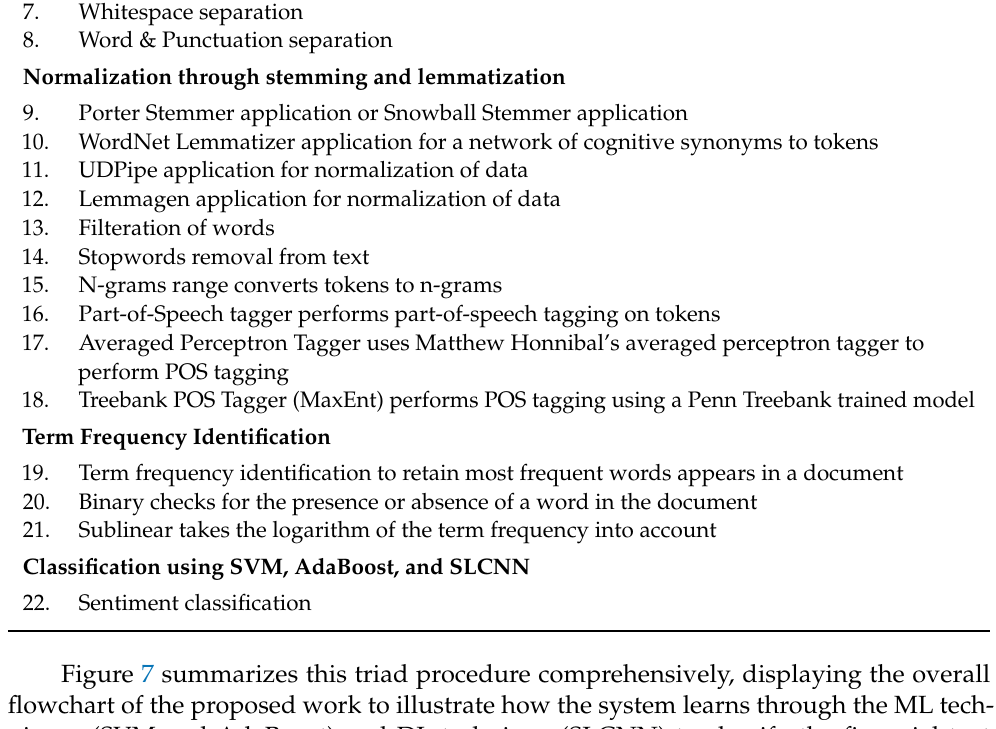
SLCNN. Hence, by analyzing the results, SLCNN provides the best classification result compared to the SVM and